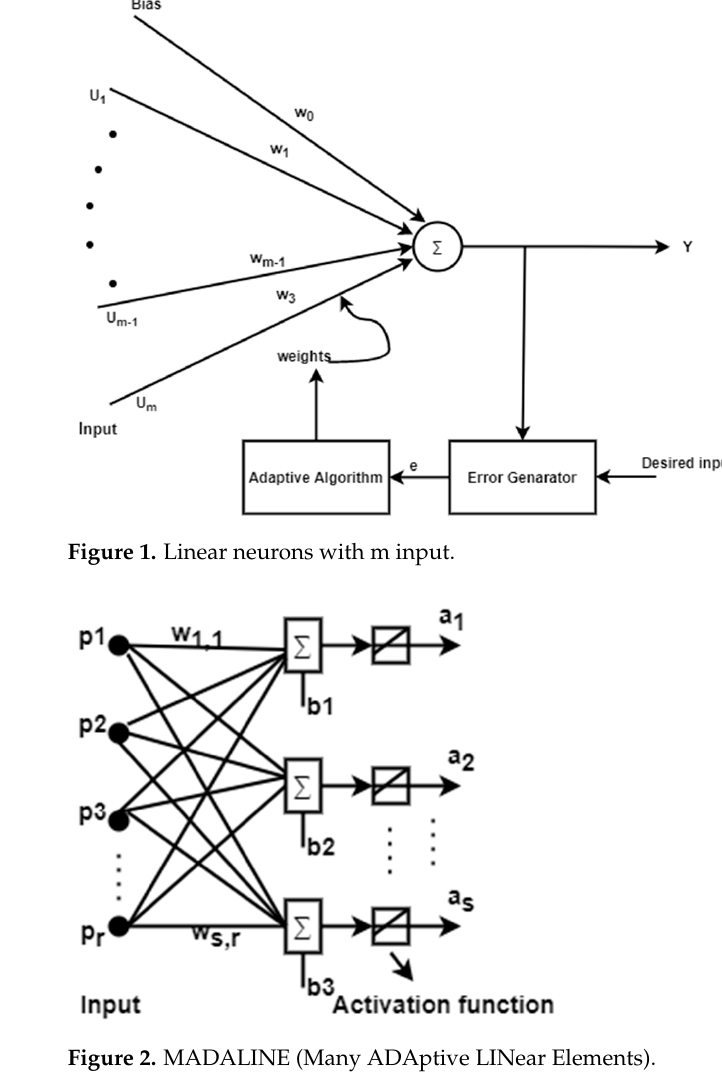
Figure 2. MADALINE (Many ADAptive LINear Elements).